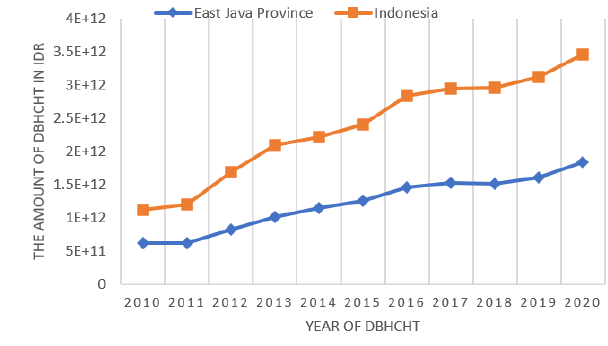
Figure 5. The trend of Revenue Sharing Fund of Tobacco Products Excises (DBHCHT) from 2010 to